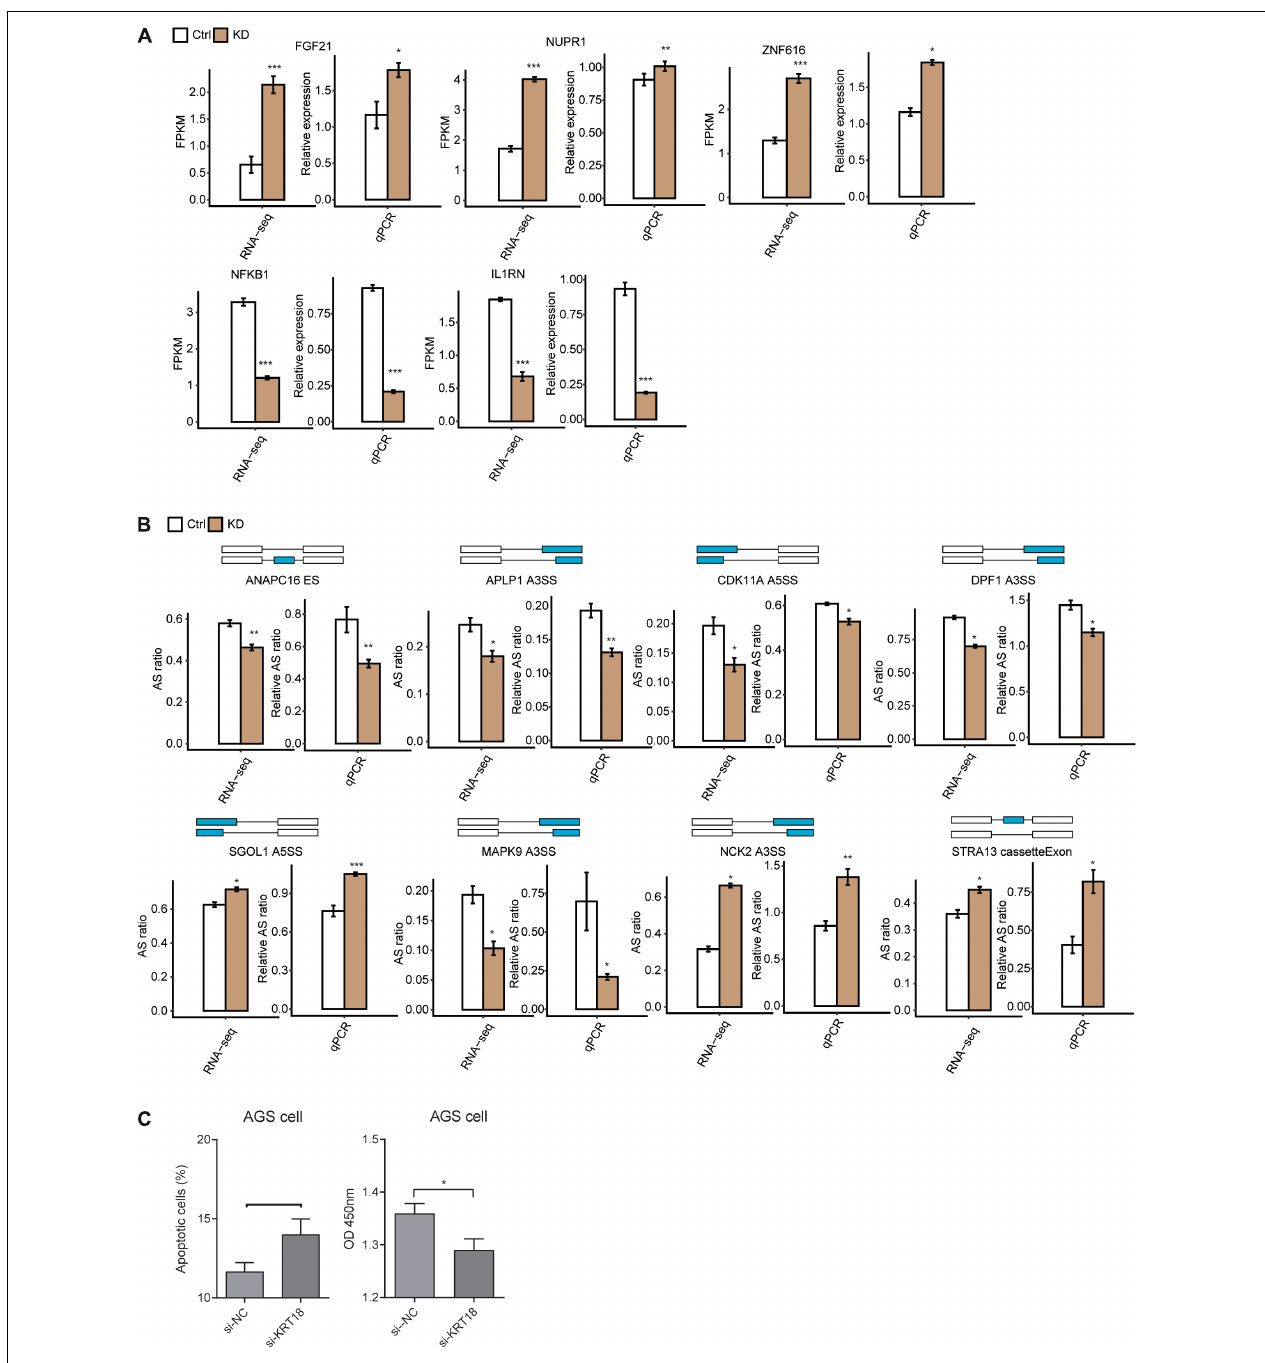
FIGURE 3 | Validation of KRT18-affected expression and alternative splicing of genes related to cell proliferation and apoptosis in AGS cells. (A) Validation of KRT18-regulated gene expression by RT-qPCR in AGS cells. Gene expression quantified by RNA sequencing data and qRT-PCR. FPKM values were calculated as explained in section “Materials and Methods.” (B) Validation of KRT18-regulated alternative splicing events (RASEs) in genes related to cell cycle or apoptosis process by RT-qPCR in AGS cells. The schematic diagrams (top panel) depict the structures of ASEs, AS (altered splicing events), and M (model splicing events) (alternative exon was labeled in blue). The exon sequences are denoted by boxes and intron sequences by the horizontal line. RNA-seq quantification and RT-qPCR validation of ASEs are shown in the bottom panel. The altered ratios of AS events in RNA-seq were calculated using the formula: AS junction reads/(AS junction reads + M junction reads), whereas the altered ratios of AS events in RT-qPCR were calculated using the following formula: AS transcripts level/M transcripts level. Error bars represent mean ± SEM. * p < 0.05, ** p < 0.01, *** p < 0.001, Student t -test. (C) Bar plot showing the apoptotic level (left panel) and proliferation level changes of AGS cells after